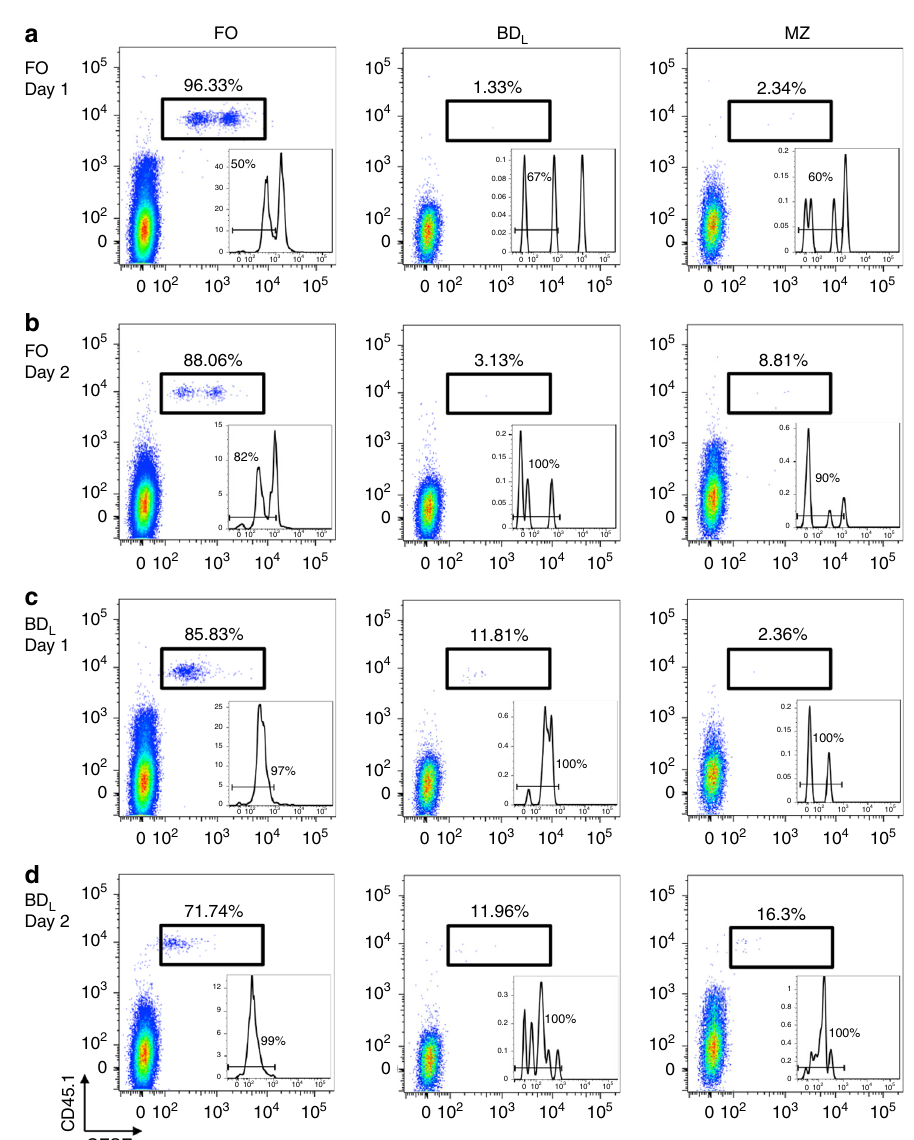
Fig. 7 Following adoptive transfer a subset of BD L are stable phenotypically. C57BL/6 CD45.1 FO ( a , b ) or BD L ( c , d were FACS puri fi ed, CFSE labeled, and adoptively transferred (1.5 × 10 6 ) into C57BL/6J CD45.2 mice that were sublethally irradiated (500 rad) 11 days prior. On days 1 and 2 the presence of FO, BD L , and MZ B cells was assessed in the spleen. The transferred cells were gated as CD45.1 + and the percentage of each B cell subset within the gate is provided and shown as dot plots with CFSE. The inset is a histogram of the CFSE data with the percentage of cells having undergone proliferation